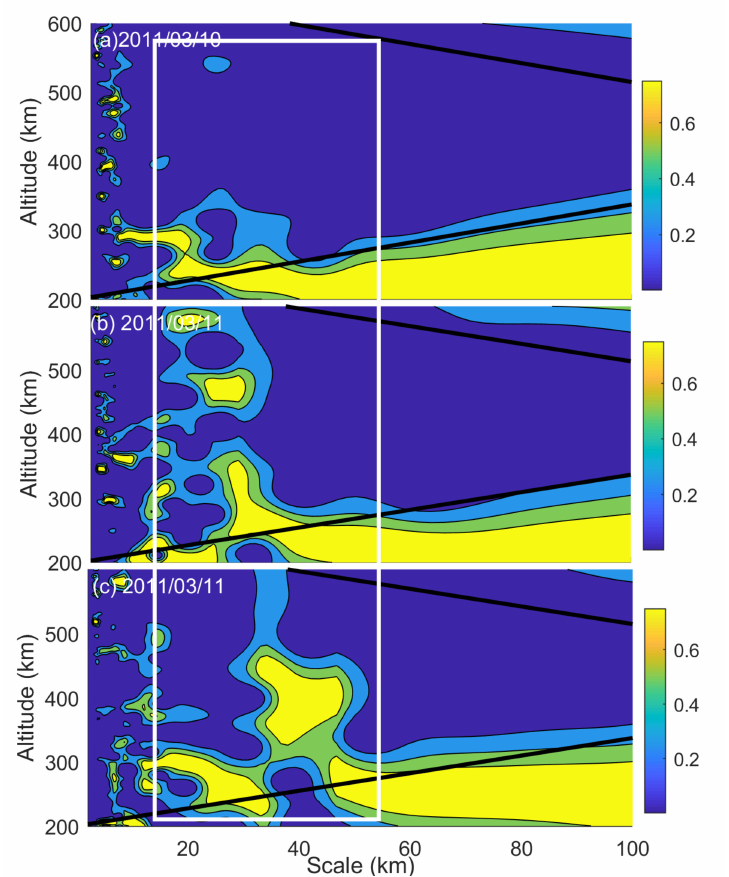
Figure 8. Wavelet analysis of the detrended total electron content (DTEC) profile variations on 10 and 11 March 2011. ( a ) The spectrum analysis of the DTEC on 10 March 2011. ( b , c ) The spectrum analysis of the DTEC variations recorded during 11:45–12:05 UT and 11:55–12:36 UT, respectively, on the earthquake day. The vertical white lines mark the time period when the ionospheric disturbances were observed. The black oblique lines indicate the cone of influence.